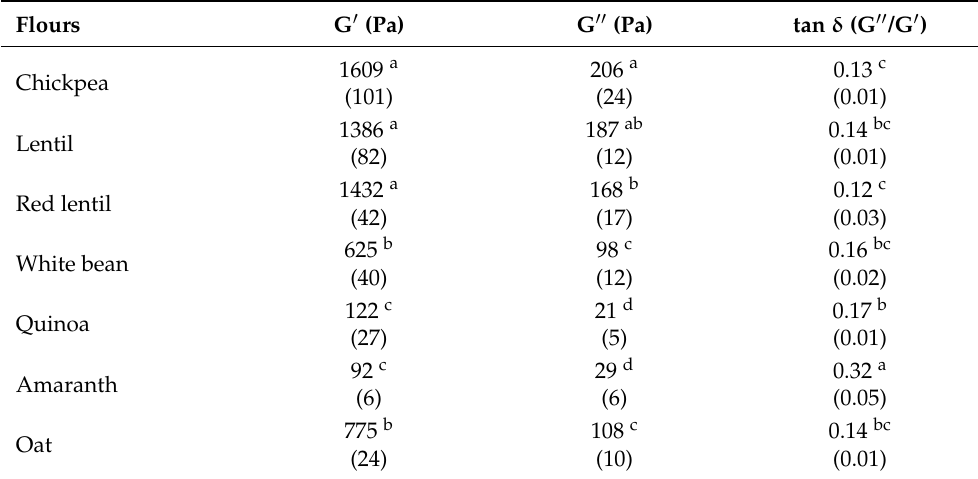
Table 5. Mean values of the storage modulus (G (cid:48) ), loss modulus (G (cid:48)(cid:48) ), and loss tangent (tan δ ) values at 1 Hz of the flour pastes. Standard deviation in brackets.